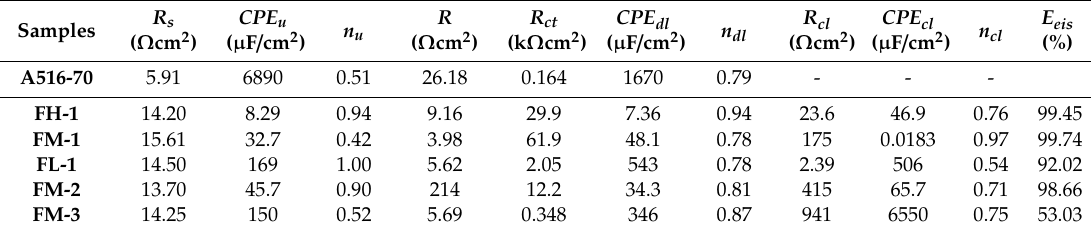
Table 4. EIS parameters for the bare steel, unprocessed Al and cladded samples after 21-day immersion in 3.5% NaCl medium.